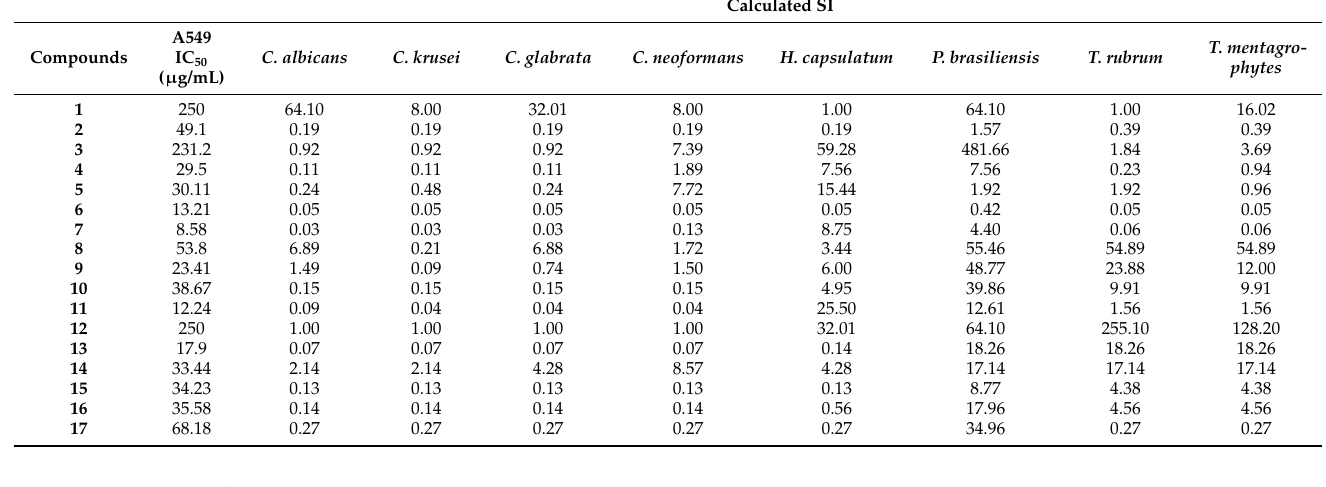
Table 4. Selectivity index (MIC 90 /IC 50 ) of nitrofuran derivatives against different fungi species compared to an A549 lung cell. Calculated SI